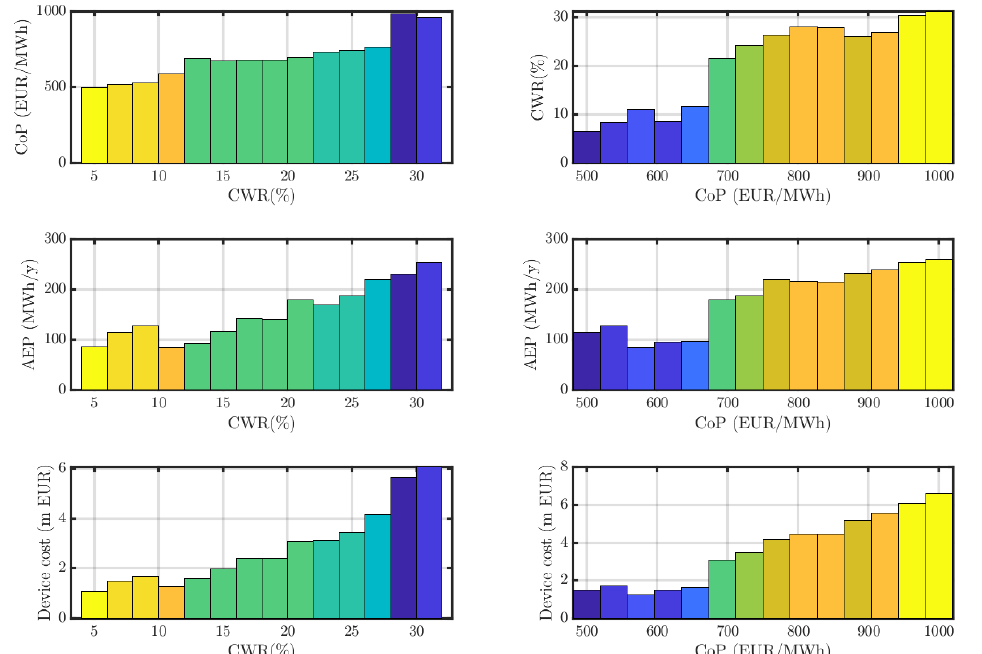
Figure 18. On the left: 14 individuals with the highest CWRs for each CWR-bin, with bars coloured proportionally to CWR. On the right: 14 individuals with the lowest CoPs for each CoP-bin, with bars coloured proportionally to 1/CoP.